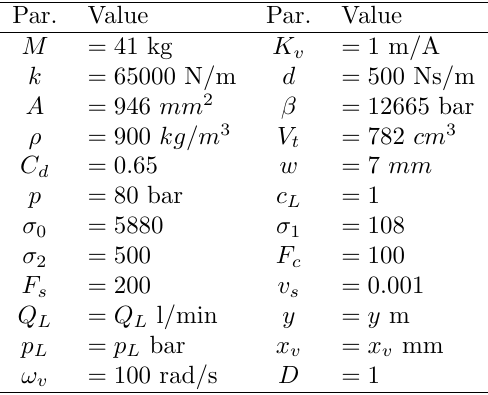
Figure 1: Translational hydraulic-mechanical system. The parameters of the system are given in Table 1. Table 1: Values of the system parameters with hy- draulic